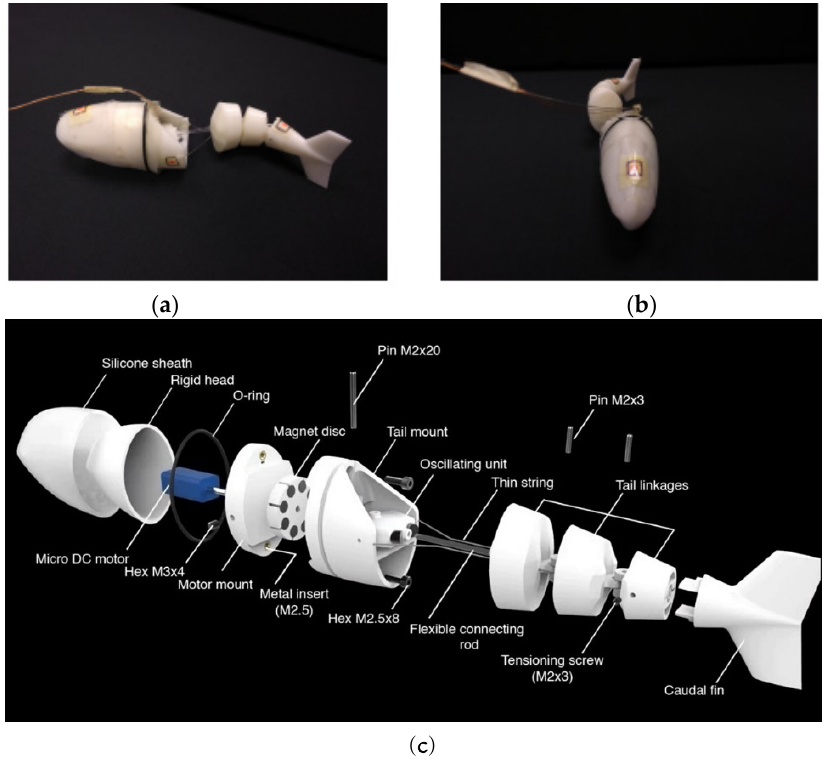
Figure 1. Final fabricated robotic fish. Hydrodynamic waterproof head, three links, and power supply wires are visible. ( a ) Lateral view of the prototype; ( b ) frontal view of the prototype; ( c ) exploded view of the final CAD assembly of the robotic fish. The micro gear motor was housed inside the head. Permanent magnets were inserted into the rotating disc and into the oscillating unit. The flexible connecting rod and the lateral wires simulate the flexible spinal cord and the lateral muscular fibers, respectively, of a real